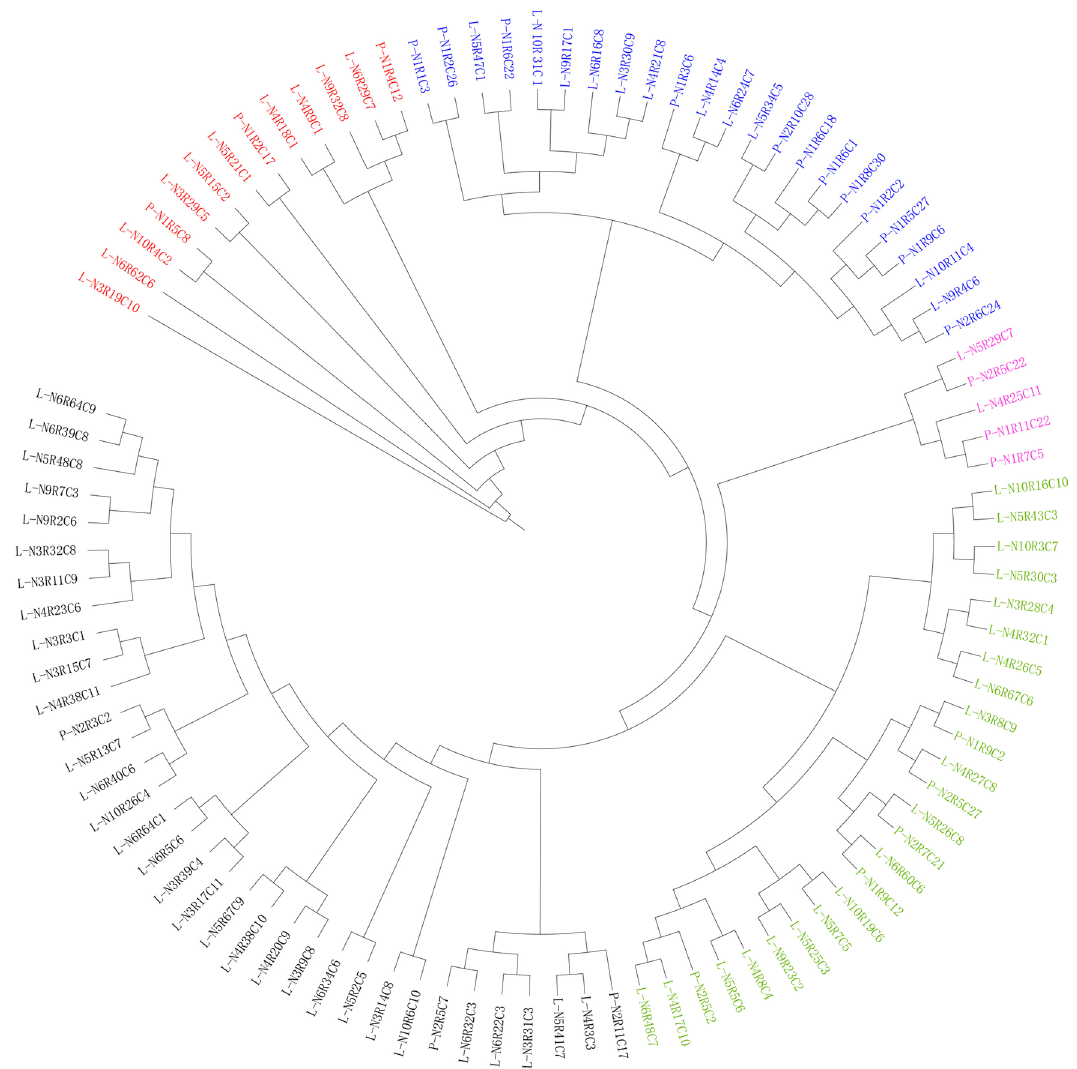
Figure 1. Population with 100 individuals were divided into 5 groups, separated by different colors. Phylogenetic tree of Calamansi constructed by SNPs genotypes extracted from a seedling population with 100 individual’s (figure is generated by iTOL software, Version iTOL 6.0, https:// itol. embl.